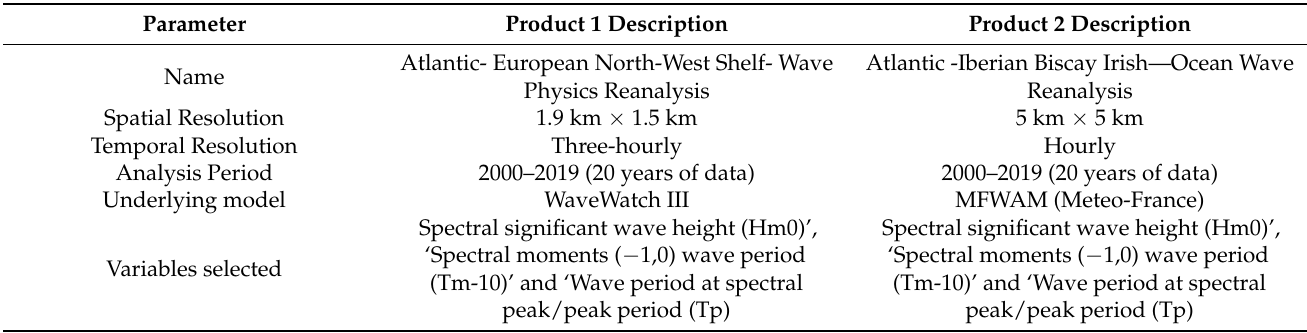
Table 1. Details of wave data downloaded.